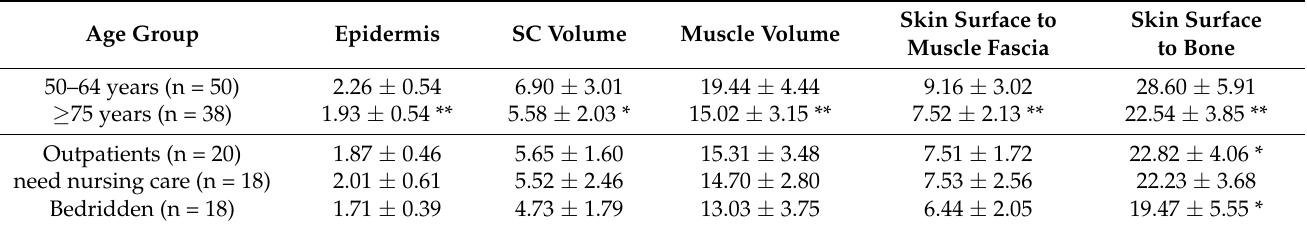
Table 3. Depth from the skin surface to muscle fascia and that to the